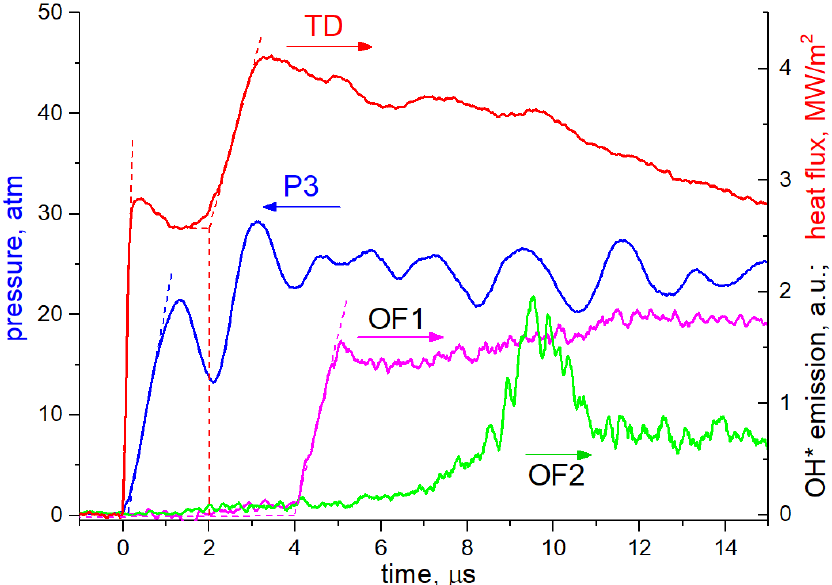
Figure 2. Exp. #1 time histories for P3 [atm], OF1 and OF2 [a.u.], TD [MW/m 2 ]. Dashed lines are tangents to baselines.